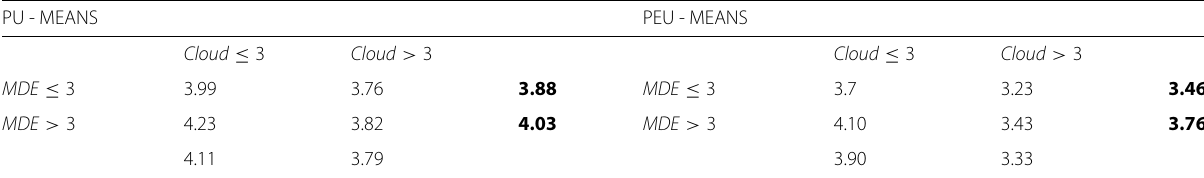
Table 4 Two-way ANOVA analysis results PU - MEANS PEU -